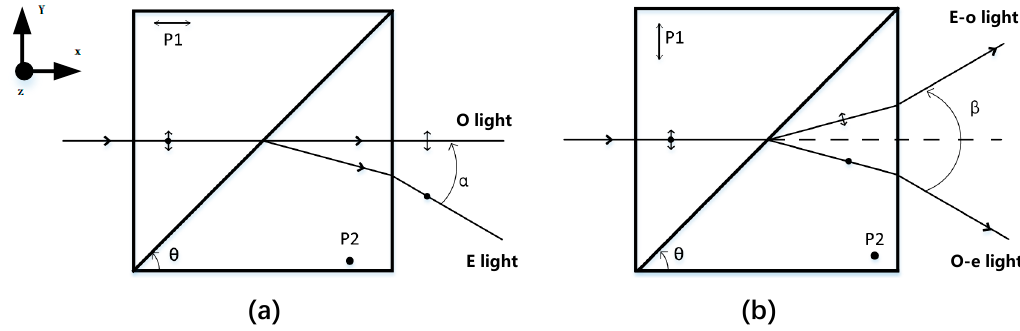
Figure 1. Schemes of ( a ) a Rochon Prism and ( b ) a Wollaston Prism, where the line of dashes is the optical axis of the system.